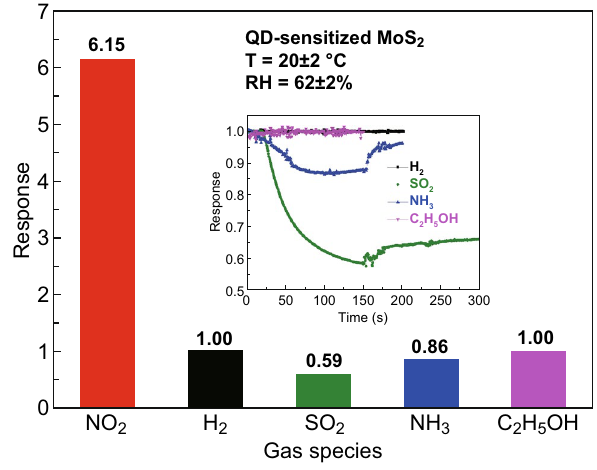
Fig. 5 Selectivity of QD‑sensitized MoS 2 gas sensors toward differ‑ ent gases: 10 ppm NO 2 , H 2 , SO 2 , NH 3 and 200 ppm C 2 H 5 OH